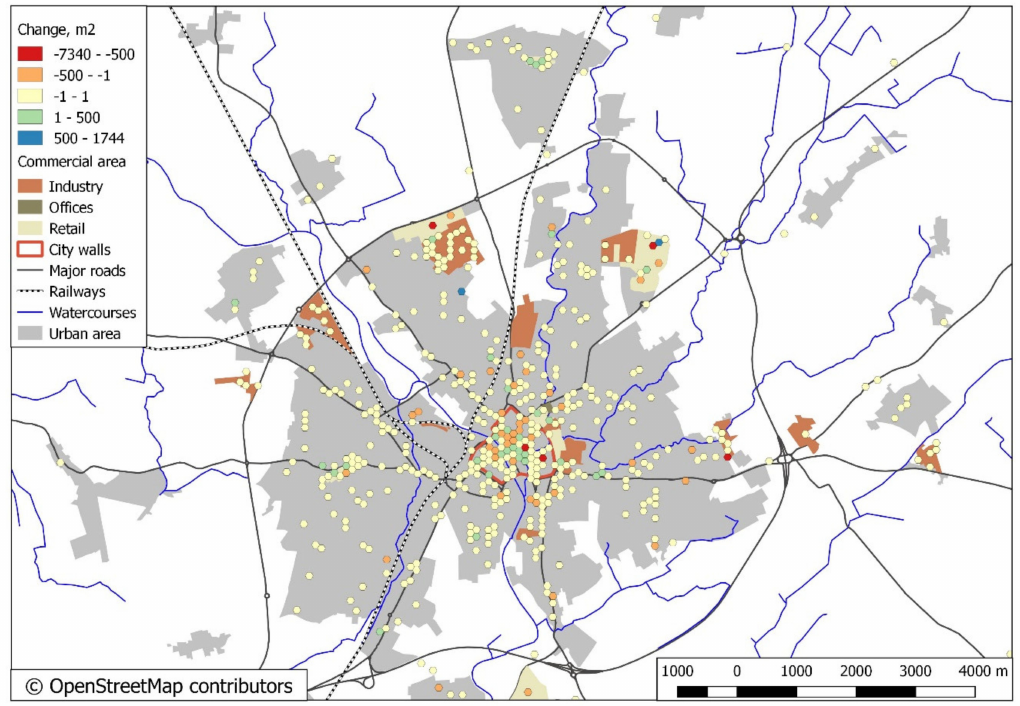
Figure 8. Change in retail property floorspace distribution,